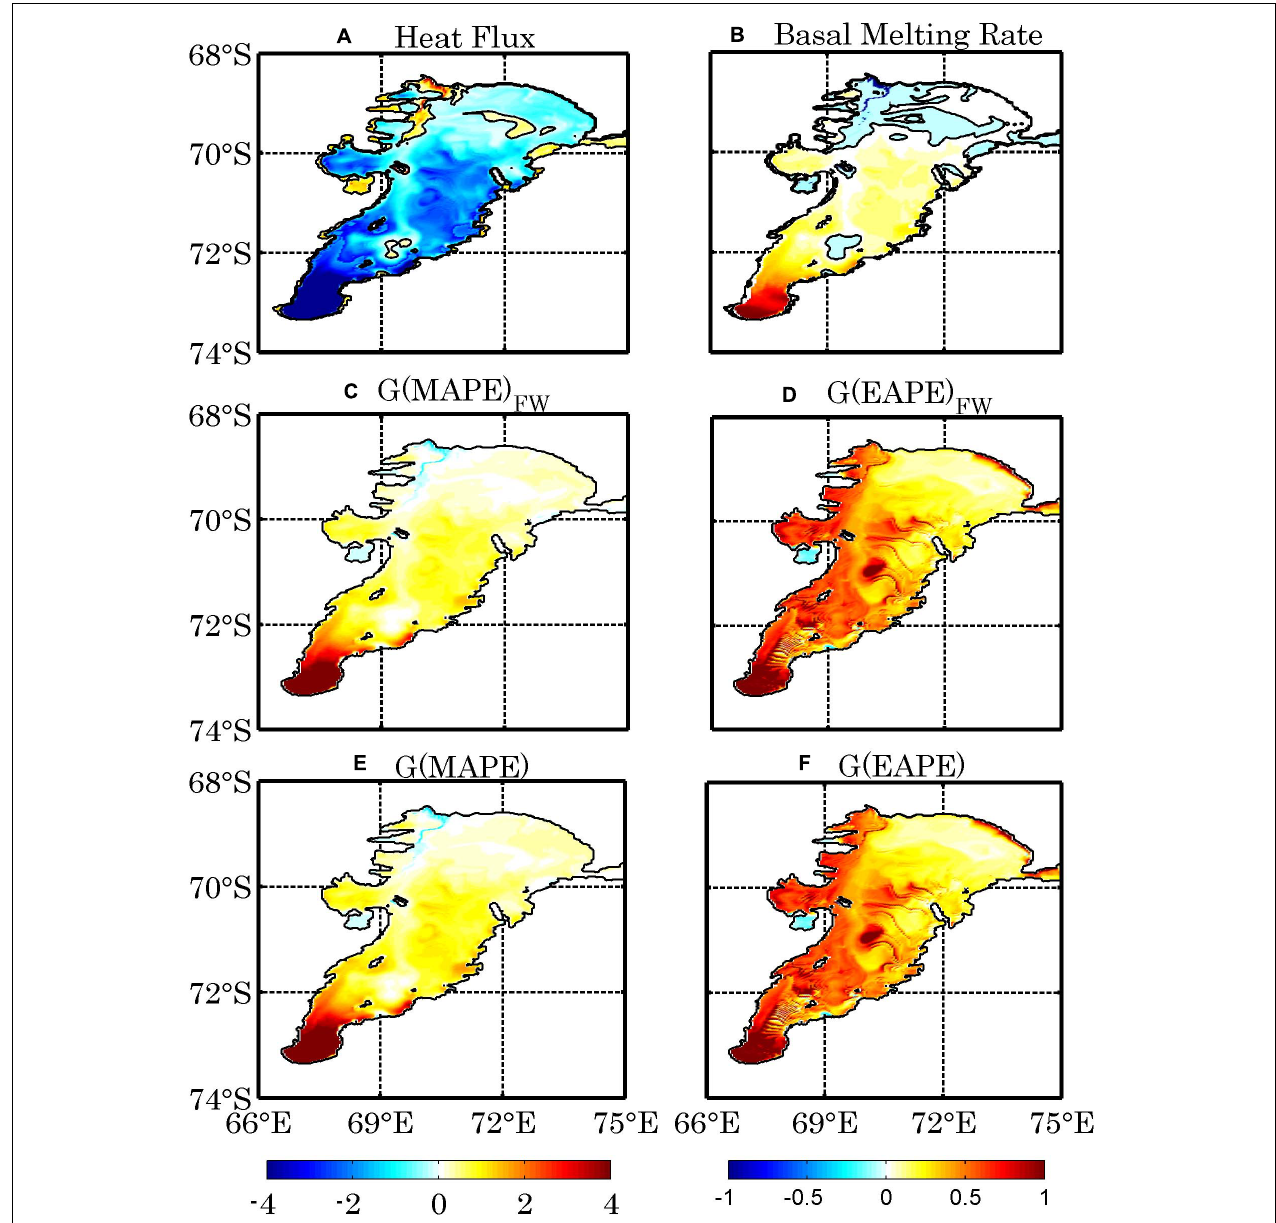
FIGURE 6 | The annual mean net heat flux (1 × 10 W m − 2 ) (A) and basal melting rate (1 × 10 m yr − 1 ) (B) , the generation rates induced by the freshwater flux for MAPE (1 × 10 − 2 W m − 2 ) (C) and EAPE (1 × 10 − 5 W m − 2 ) (D) at the ice shelf-ocean interface. (E,F) Are the generation rates induced by the total buoyancy flux